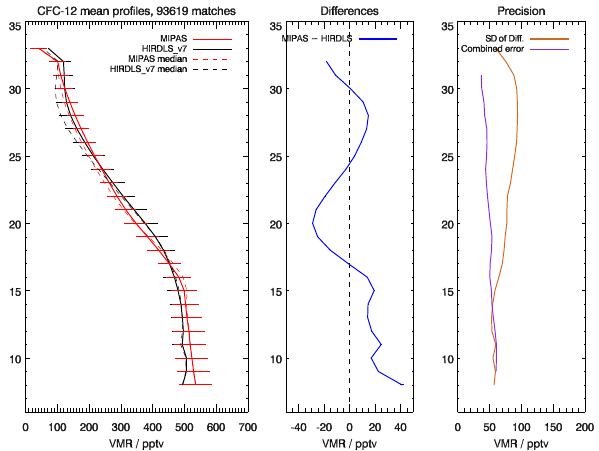
Figure 22. Comparison of mean profiles of MIPAS CFC-12 (left panel, continuous red line) and HIRDLS (left panel, continuous black line) for the years of 2005–2008. The error bars include the total error in the case of MIPAS and the estimated error – which is derived from the average of 10 sets of 12 consecutive profiles of regions with little variability (Gille et al., 2014) – in the case of HIRDLS. The dashed lines show the median of each data set. The middle panel shows the mean difference (blue) of these profiles and the standard error of the mean. The right panel shows the combined error (purple) of the instruments and the standard deviation of the differences